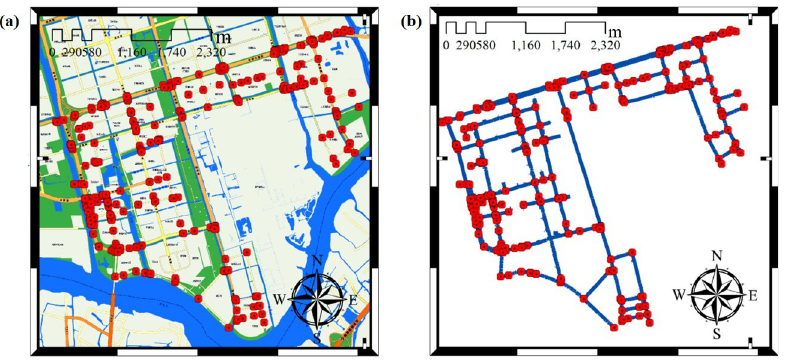
Fig 14. Necessary nodes and topological diagram of pipeline network after simplification. (a) Necessary nodes, (b) Pipeline network topology. (Republished under a CC BY license, with permission from Suzhou Industrial Park Qingyuan Huayan Water Co. LTD, original copyright